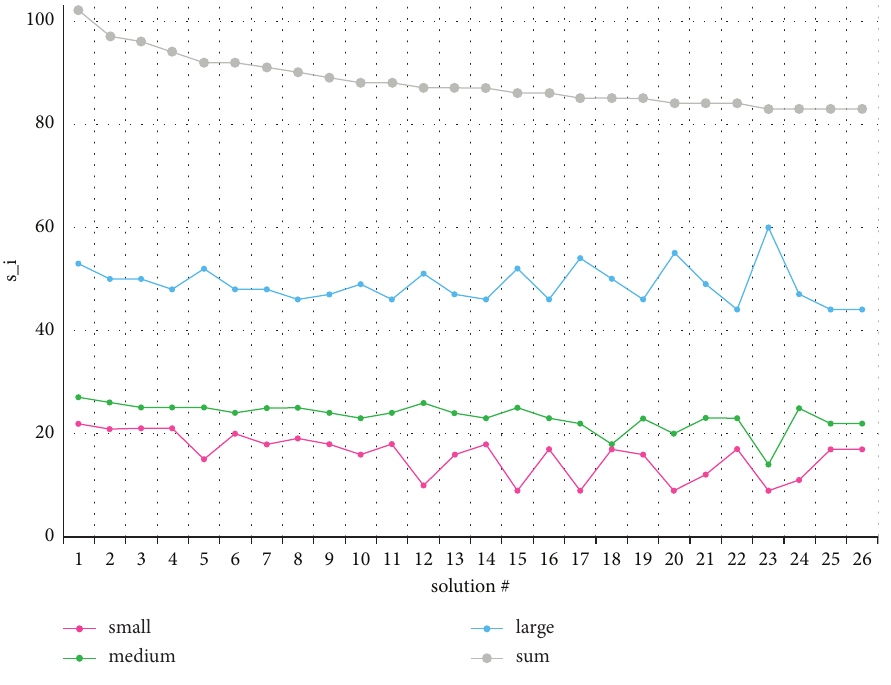
Figure 3: Number of servers.